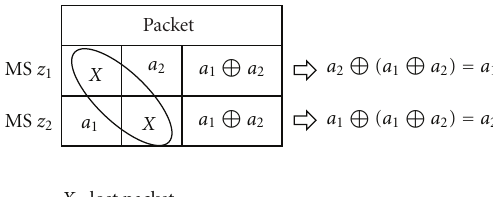
Figure 1: Illustrative example of NC